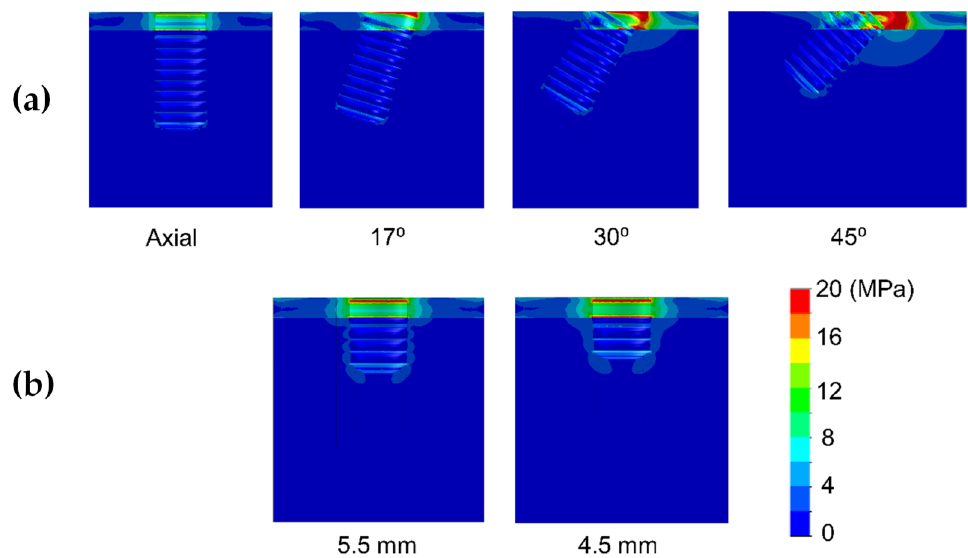
Figure 7. Von Mises stress distribution of delay-loaded long 10 mm implant ( a ) and short implants (4.5 and 5.5 mm in length) ( b ) in bone type III.